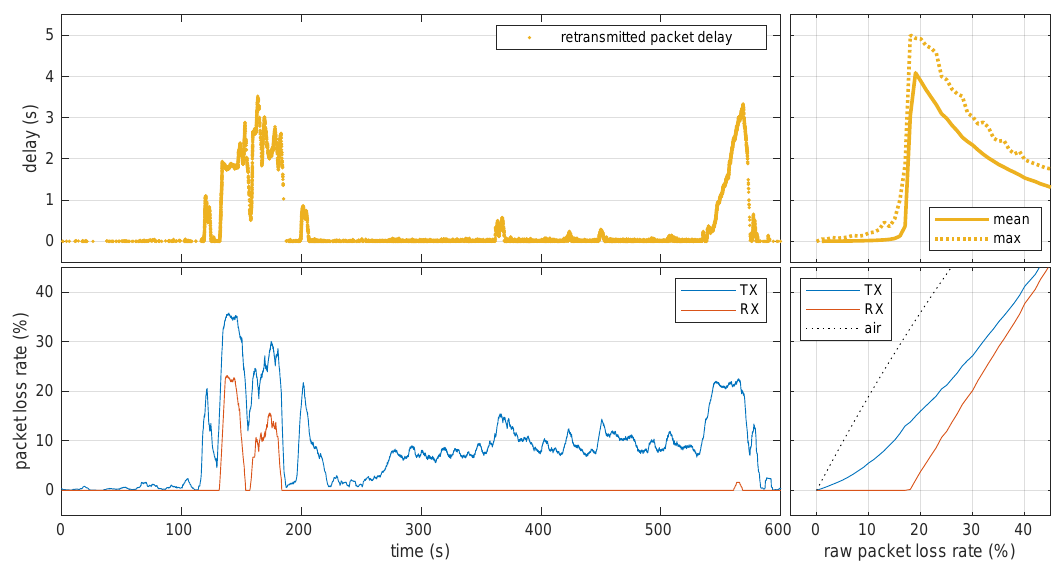
Figure 14. Results of a retransmission efficiency experiment (left panels) and of a steady-state system simulation (right panels). The yellow lines are the delays introduced by retransmissions. The blue lines (TX) are the average fraction of packets discarded by the transmitter due to radio channel congestion. The red lines (RX) are the average fraction of missing packets at the receiver. The dotted black line (air) denotes the air-time capacity reduction of the radio channel due to missed packets and connection events (see text for